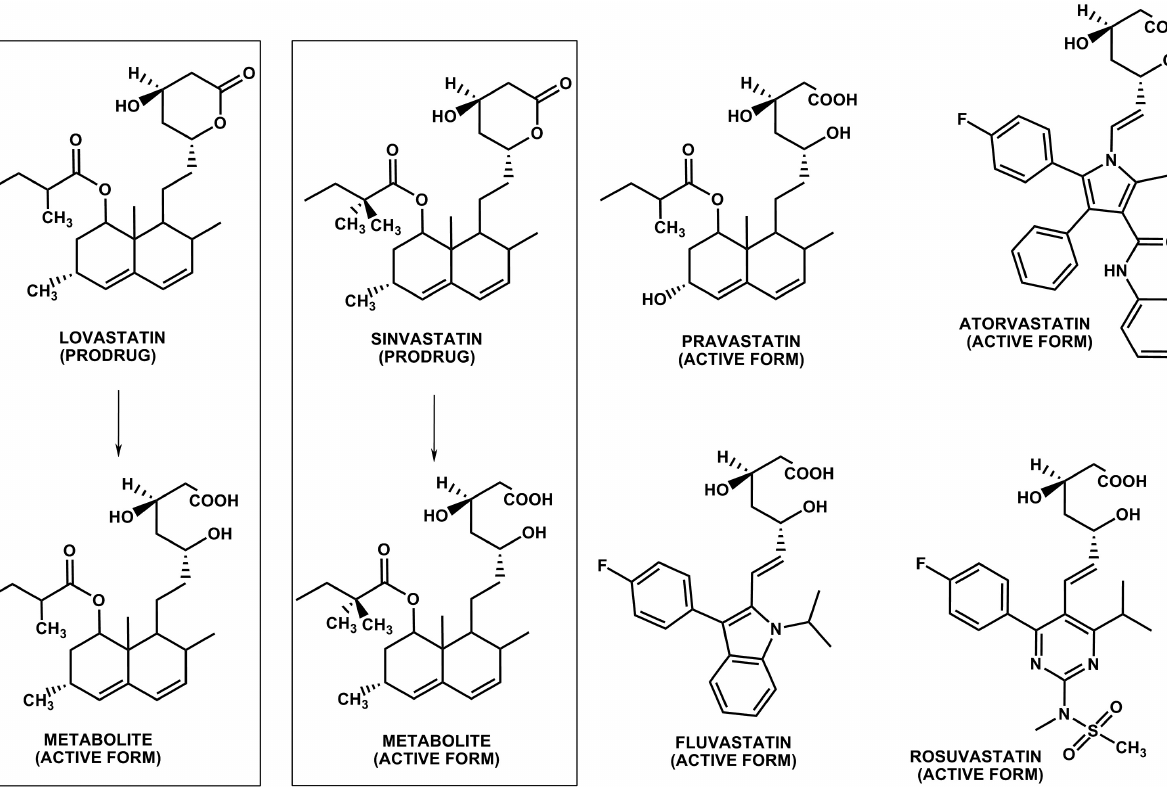
FIGURE 8 - The structure of mevastatin, of its active metabolite and the similarity to the HMG-CoA reductase substrate (intermediary).